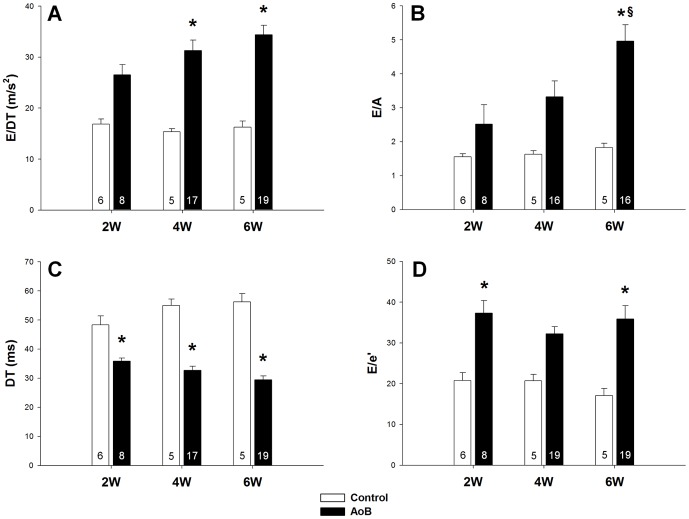
Pressure overload caused changes in transmitral and tissue Doppler parameters of diastolic function.Changes in the deceleration rate E/DT (A), the E/A ratio (B), the deceleration time DT (C) and the E/e' ratio (D) in control and pressure overloaded rats at 2, 4 and 6 weeks after aortic banding (AoB). Data are mean ±SEM. Significantly different vs. age-matched control: *, vs. AoB at 2 weeks: §. The numbers in the bars indicate group size.